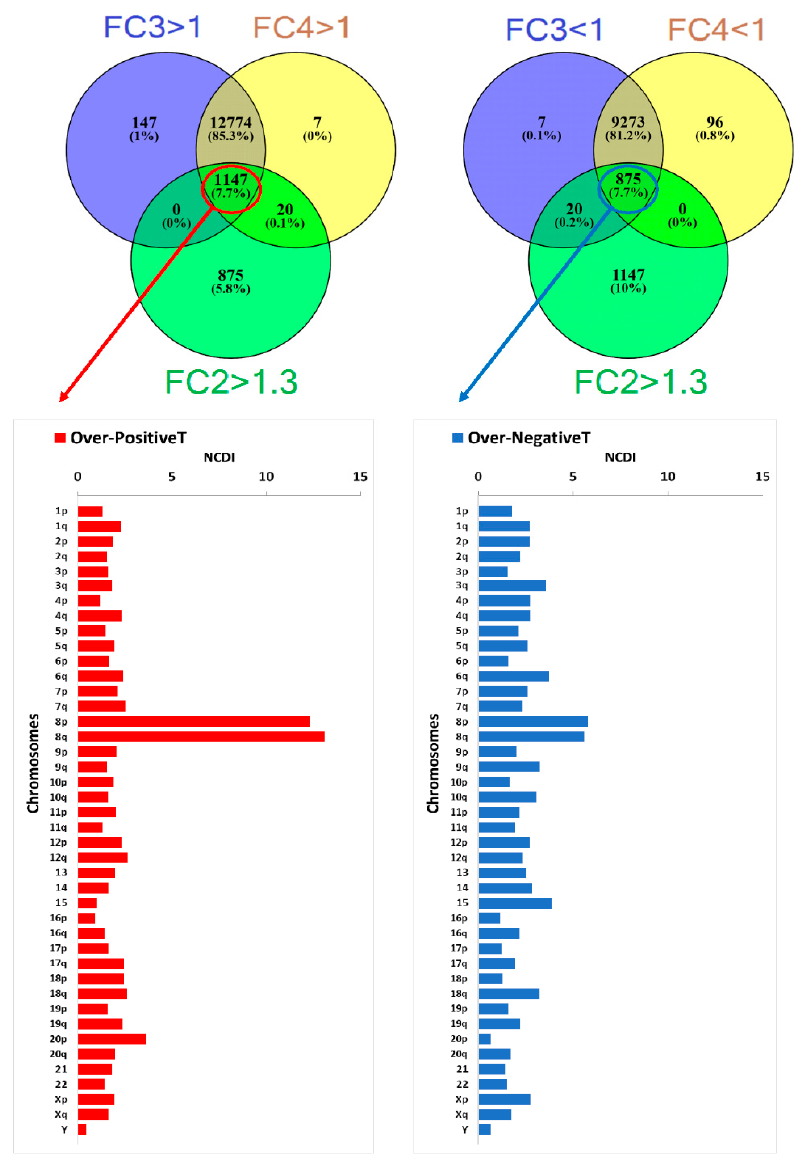
Figure 5. (Top) Venn Diagrams showing the number of transcripts expressing levels higher or lower than an established fold-change value. (Bottom) Normalized Chromosomal Distribution Index (NCDI) of Over-PositiveT (transcripts with FC2 > 1.3, FC3 > 1, FC4 > 1) or Over-NegativeT (transcripts with FC2 > 1.3, FC3 < 1, FC4 < 1) in all chromosomal arms and acrocentric chromosomes. Results have been obtained by analysing the Chr8 control COAD group, wChr8-gain COAD group and normal colonic mucosae.